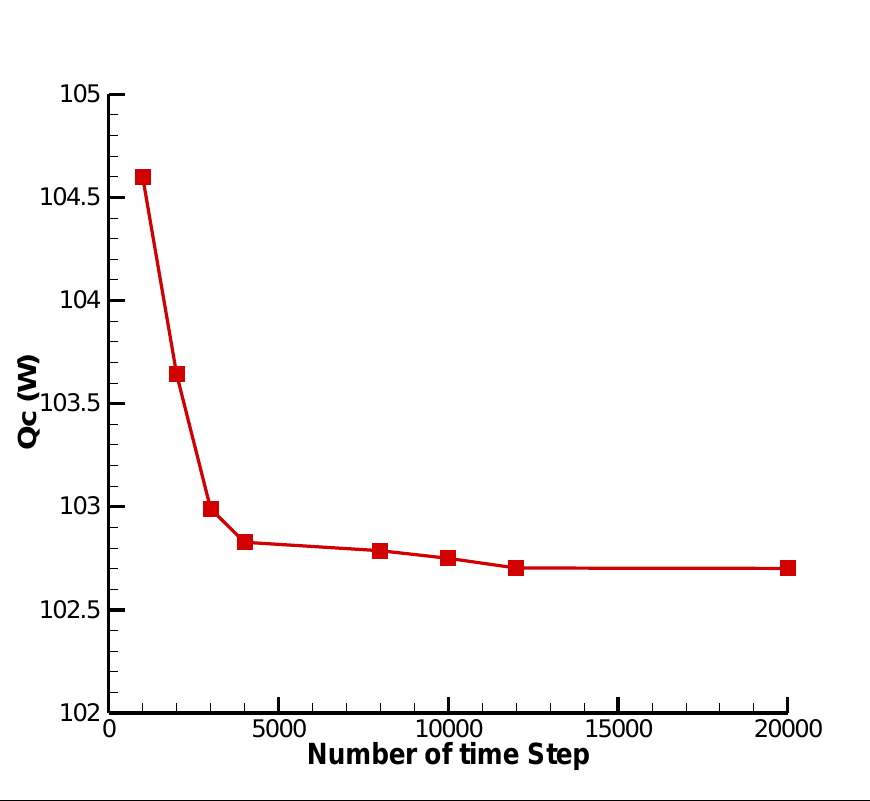
Figure 6. Independence of the results from the temporal step disjoining.